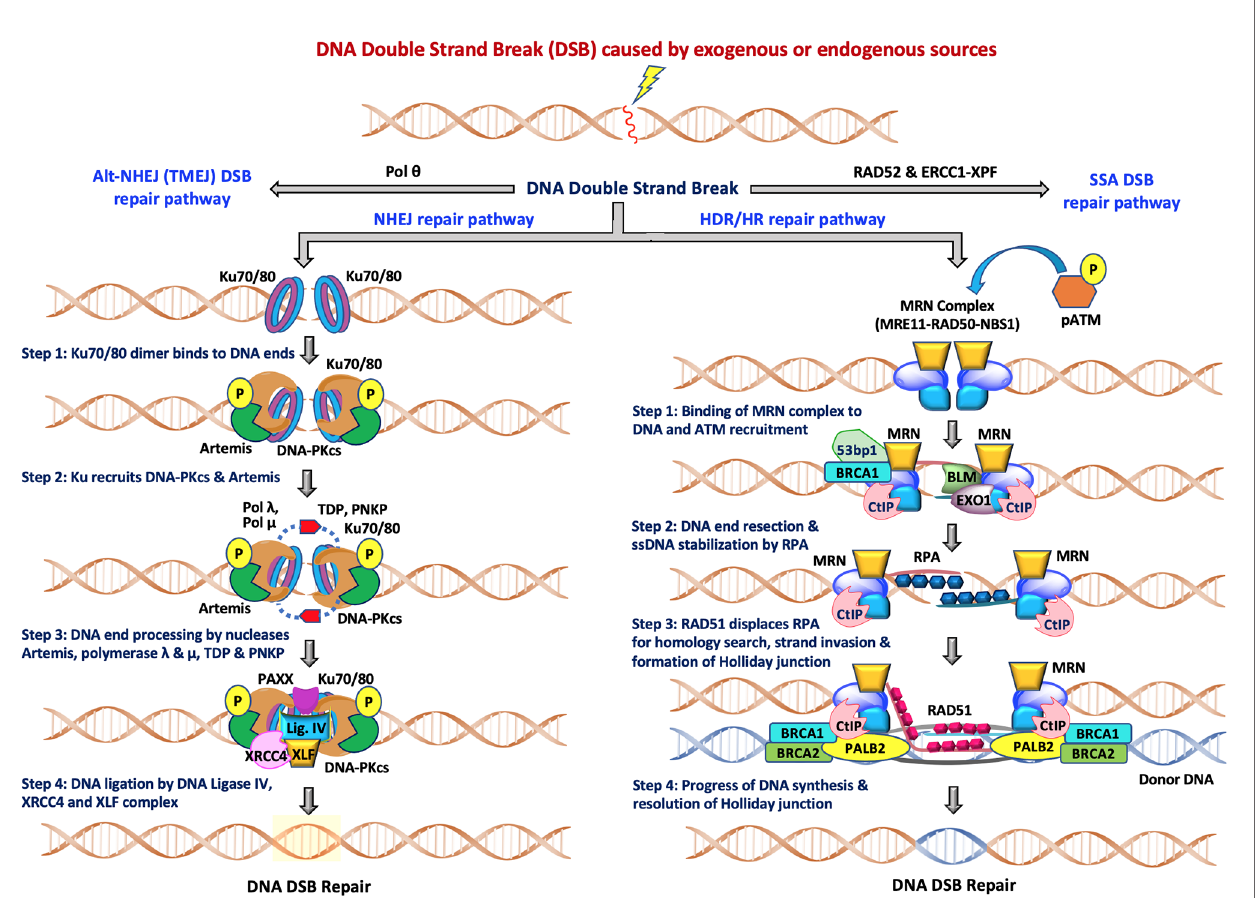
FIGURE 1 | The two major pathways of DNA double-strand break repair: During NHEJ, the DNA double strand sites are initially recognized by heterodimeric Ku70/ 80. This is followed by recruitment of DNA-PKcs and Artemis, DNA end processing by Artemis, polymerase l and m , TDP and PNKP and fi nally ligation of DSB breaks by Ligase IV/XRCC4/XLF complex for completion of the repair pathway. The other accessory proteins like APLF, PAXX and XLF also participate in the repair functions. During HDR/HR, DSBs are recognized and resected by the MRN complex to generate a 3 ’ overhang. BRCA2/RAD51, along with other RAD51 paralogs, binds to the RPA coated ssDNA tails after which RAD51 replaces RPA in a BRCA1-and BRCA2-dependent process, forming a presynaptic fi lament. Upon strand invasion, D-loop formation and DNA repair synthesis can be resolved through Holliday junction, after which distinct independent pathways can operate to complete the HDR repair pathway. NHEJ is available throughout interphase while HDR is restricted to S/G2 phases of the cell